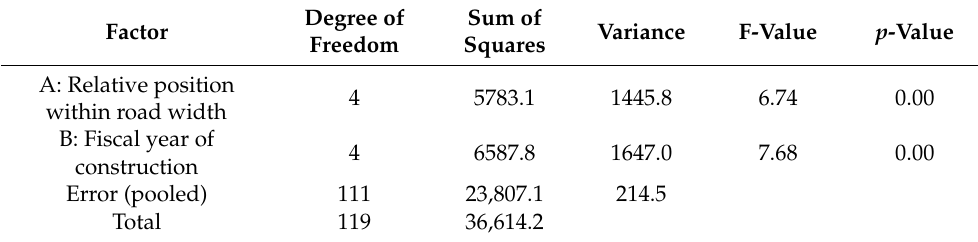
Table 3. ANOVA table of N d in Site 1.